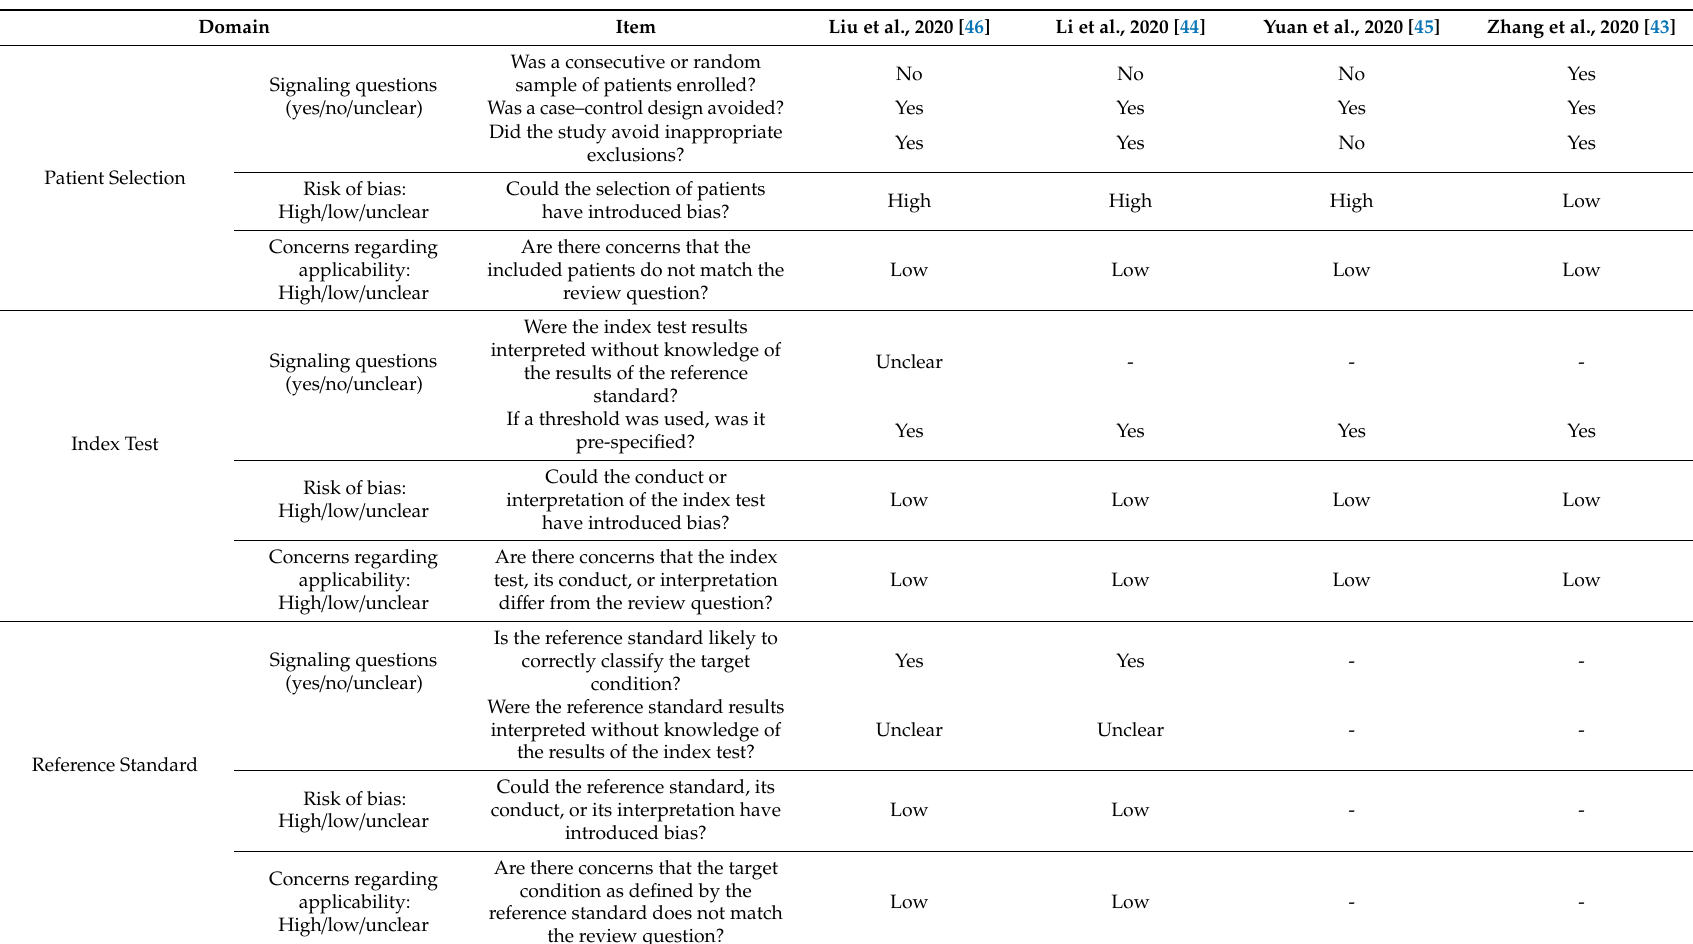
Table 2. Methodological quality evaluation of each study included in the systematic review according to Quality Assessment of Diagnostic Accuracy Studies (QUADAS; n =